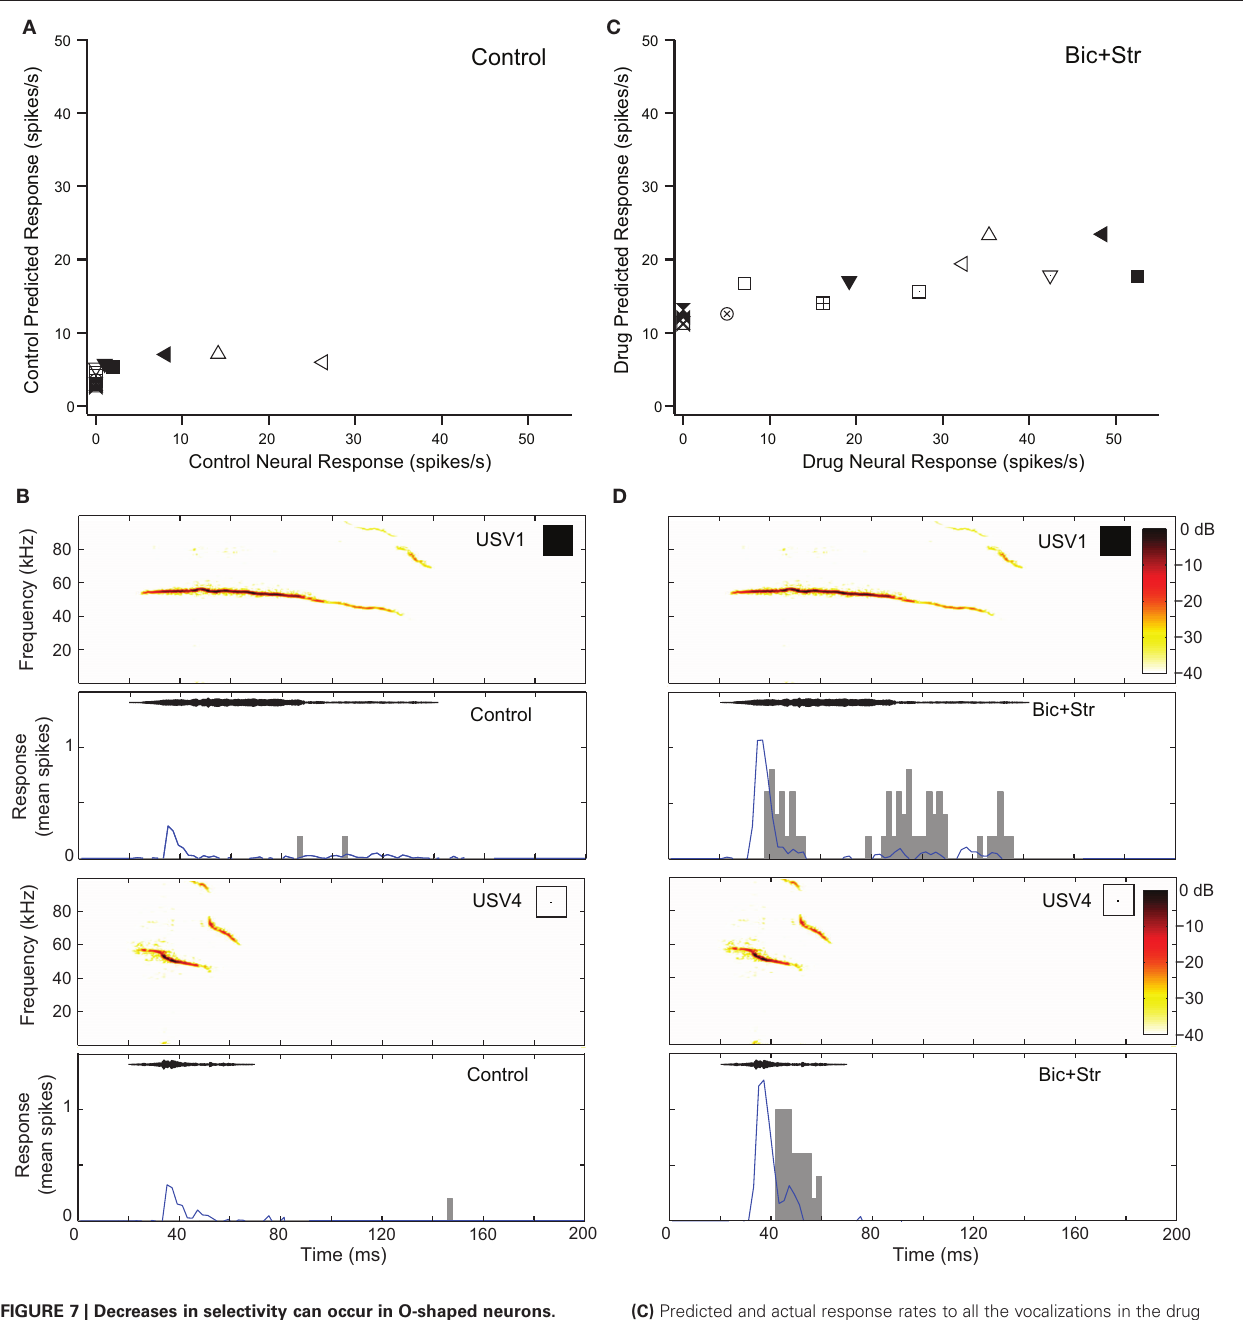
FIGURE 7 | Decreases in selectivity can occur in O-shaped neurons. (A) Predicted and actual response rates of one neuron ( Figure 2C ) to all the vocalizations in the control condition. (B) Predicted (blue lines) and actual responses (gray bars) to two vocalizations in the control condition.